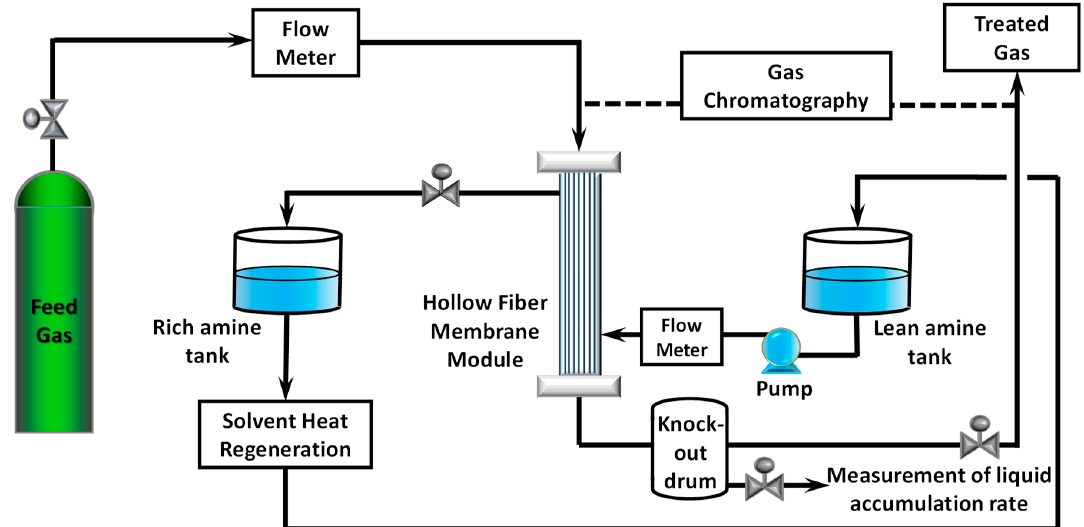
Figure 1. Schematic diagram of the membrane contactor test rig.